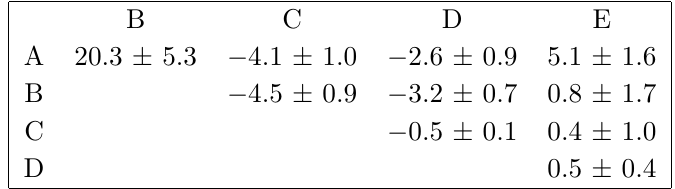
Table 5 . Interference between amplitudes, in % of the total amplitude. A denotes D +